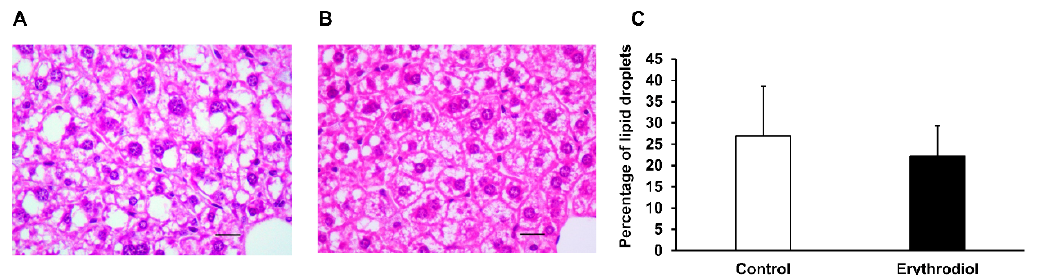
Figure 2. Hepatic histological analyses in male Apoe-deficient mice fed the different diets. Representative liver micrographs at 400× magnification from consuming a Western diet ( A ) and consuming a 10 mg/kg erythrodiol-containing Western diet ( B ). Liver sections (4 μ m) from each mouse were stained with hematoxylin and eosin and blind evaluated. Bars denote 20 μ m. Morphometric changes of hepatic fat surface in mice consuming the different diets ( C ) where data are means ± SD for each group ( n = 14 and n = 15, respectively for control and erythrodiol). Statistical analyses were done according to Mann–Whitney’s U-test.